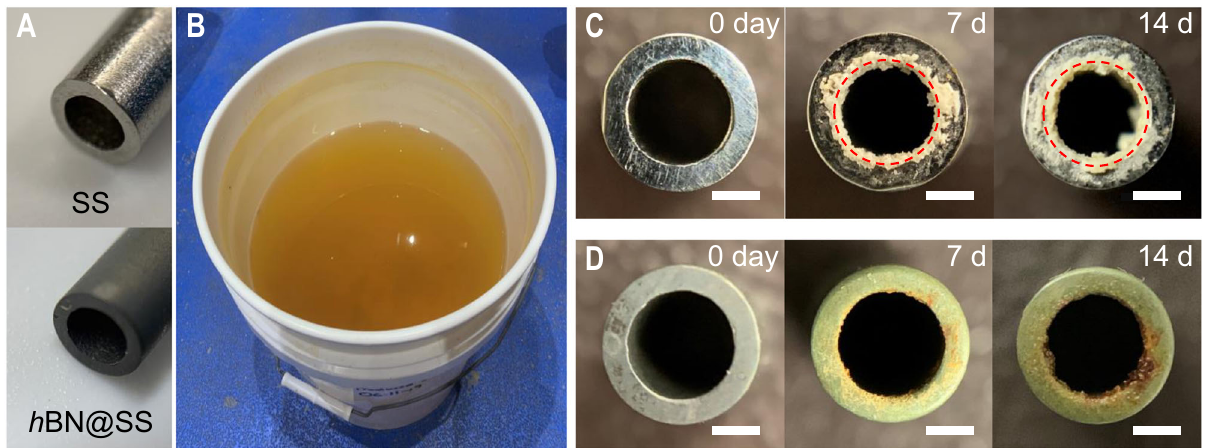
Fig.5|Scalingmitigationof h BNnanocoatinginrealoil&gasproducedwater. A Photographofstainlesssteel(SS)tubebefore(top)andafter(bottom)thegrowth of h BN nanocoating ( h BN@SS); B A photograph of produced water taken from an oil&gasproductionsiteinTexas,USA;Scalingbehaviorofthe C pristineand D h BN